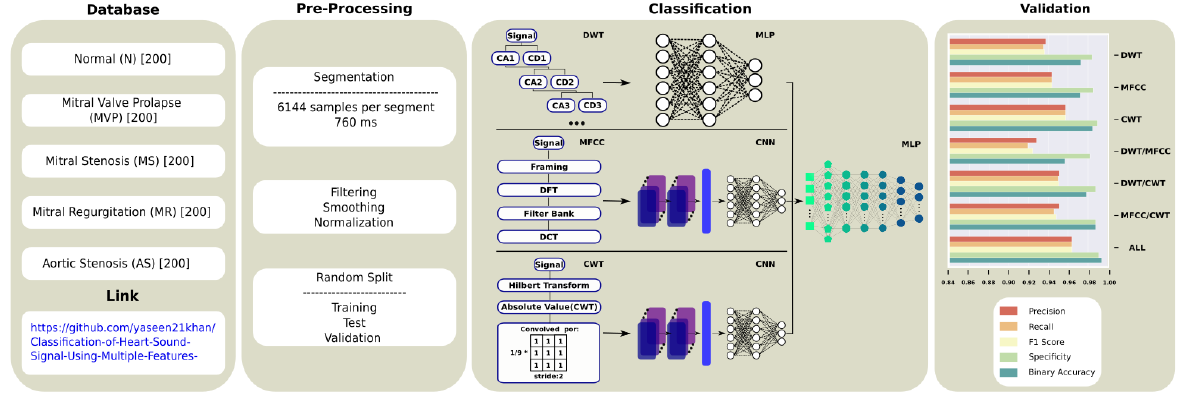
Figure 2. Block diagram of the complete